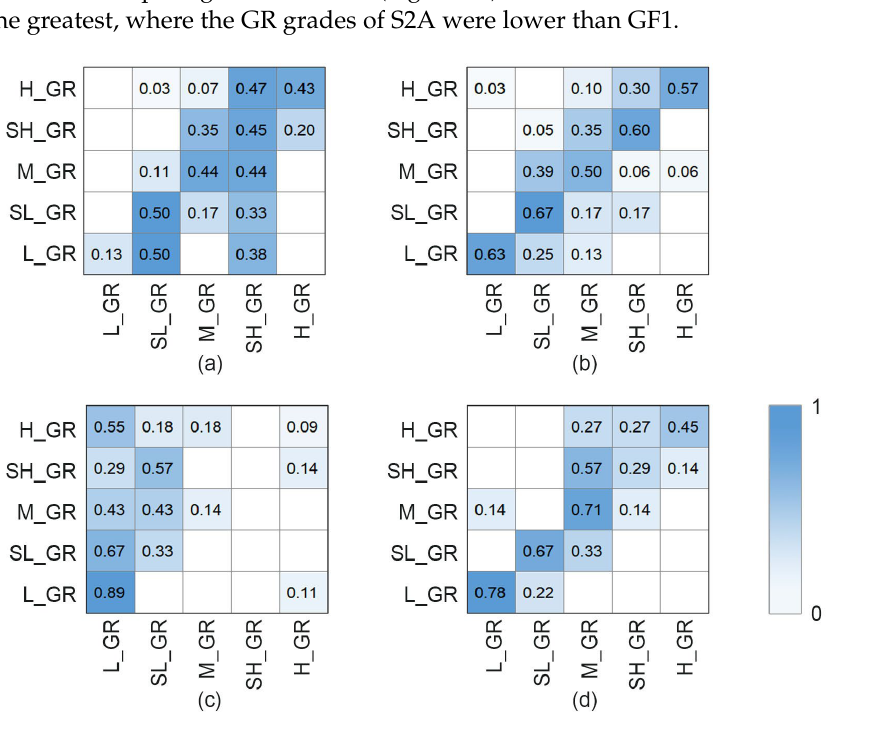
Figure 7. The confusion matrices of park land and water area: ( a ) comparison of GF1 and DJI in park land; ( b ) comparison of GF1 and S2A in park land; ( c ) comparison of GF1 and DJI in water area; ( d ) comparison of GF1 and S2A in water area.